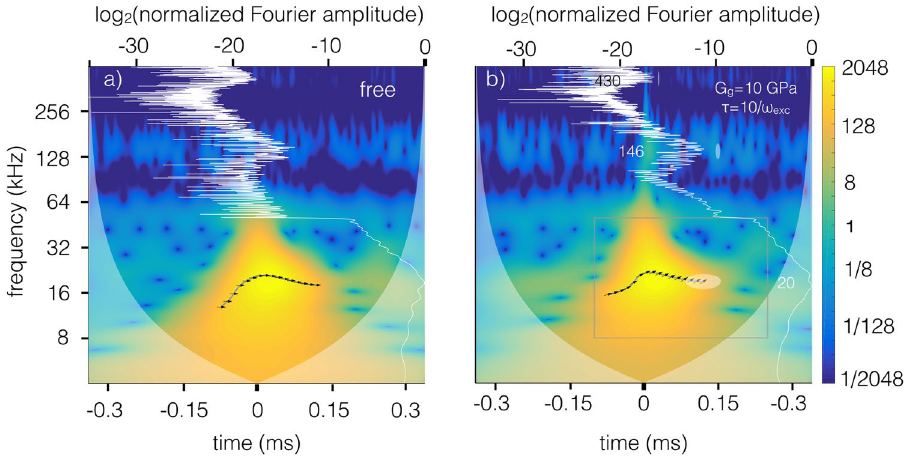
Figure 3. ( a ) Wavelet transform (bottom and left axis) of the tip trajectory for a free cantilever subject to the impulsive excitation force shown in Fig. 2(a). The free cantilever response is taken as a reference for the subsequent analysis. ( b ) Wavelet transform (bottom and left axis) of the tip trajectory of the interacting cantilever (shown in Fig. 2b)) after impulsive excitation, that is the signal to analyze. The rectangular box drawn by gray lines delimit the area pertaining to the first flexural mode. The three ellipses in the light white shade, drawn at the resonance frequencies of the cantilever modes, are the Heisenberg uncertainty areas, associated with the finite resolution of the Gabor wavelet used for the transform. Note that the shape of the uncertainty area changes with frequency. In both graphs, the frequency scale and the color scale are logarithmic base 2 (octaves). Edge effects become important in regions marked with a lighter shade on either side. The Fourier transform (white line, left and top axis) is superposed on the wavelet transform. The Fourier amplitude is normalized to one at its peak and the scale of the top axis shows the logarithm base 2 of the normalized amplitude. The peaks corresponding to the cantilever flexural modes are labeled with their frequency values. The gray line under the arrows is the instantaneous frequency associated with the first flexural mode during the cantilever excitation; the arrows’ rotation shows the instantaneous phase shift between signal and reference. Arrow pointing right: signal in phase with reference, phase shift = 0; left: signal in anti-phase with reference, phase shift = π ; up: signal leading reference by π /2, phase shift = π /2; down: signal lagging reference by π /2, phase shift = − π